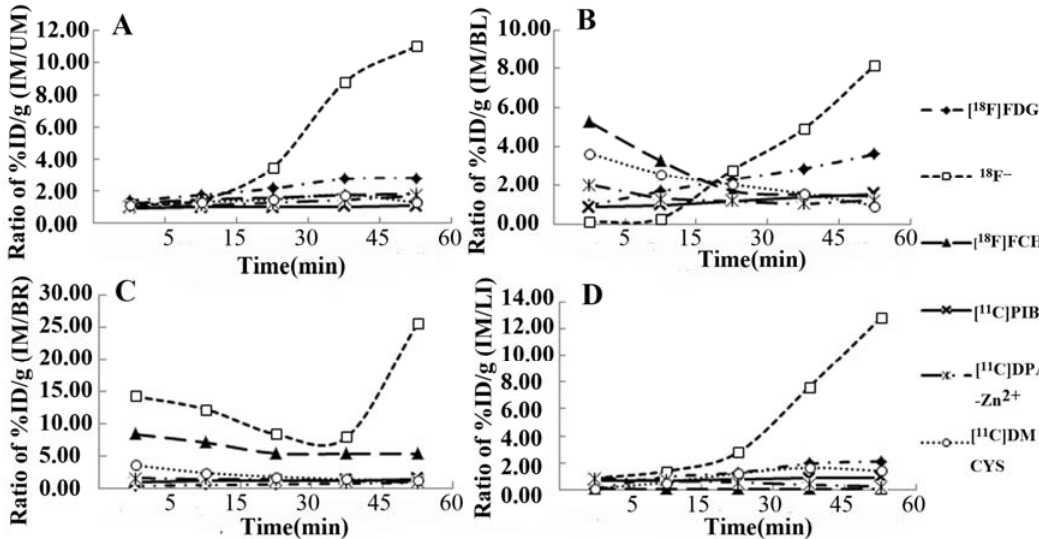
Figure 2. Time-uptake ratios curves of six PET tracers including IM/NM ( A ), IM/BL ( B ), IM/BR ( C ) and IM/LI ( D ) at different time. The 18 F − uptake ratios was progressively elevated toward 60 min after tracer administration, clearly contrasting with the other five tracers.